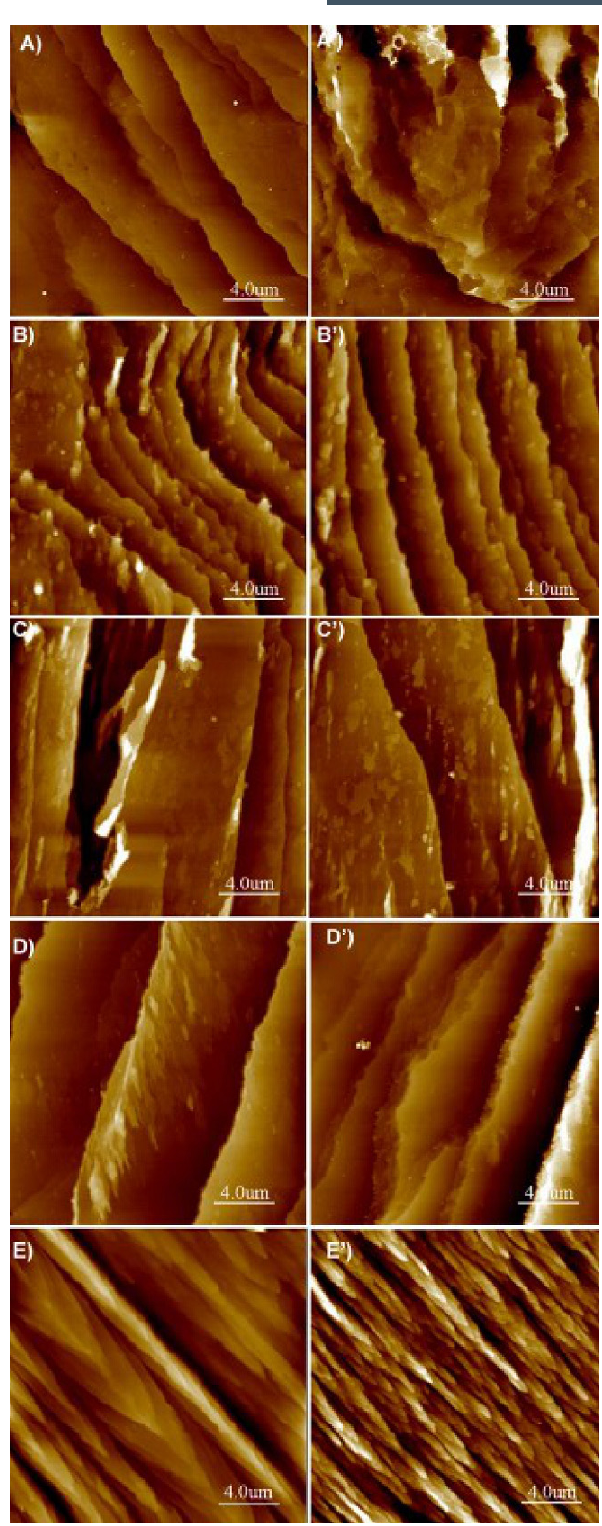
Figure 2. Changes in crystal surface structures by annealing at 80 °C for one hour. (A) pure PETN, (B) Ca-doped PETN, (C)Na-doped PETN, (D) Fe-doped PETN, (E) Zn-doped PETN before annealing; and (A’), (B’), (C’), (D’) and (E’) for corresponding surface structure after